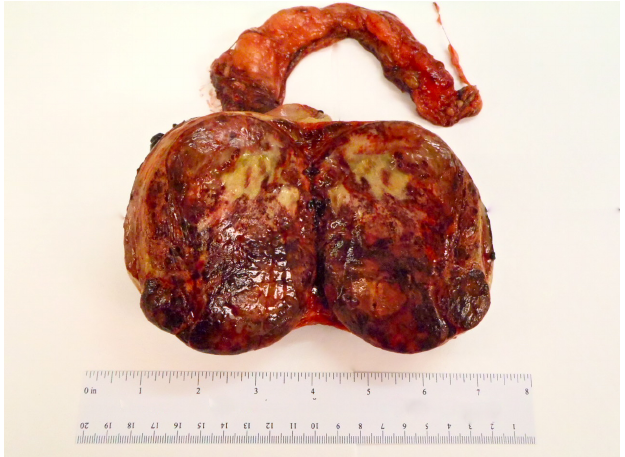
Figure 1: The orchiectomy specimen covered with a smooth red-tan intact tunica vaginalis. The cut surface revealing areas of hemor- rhage, necrosis, and white, solid fibrotic tissue. No residual testicu- lar tissue is grossly identified. The adjacent spermatic cord and epi- didymis was grossly uninvolved by